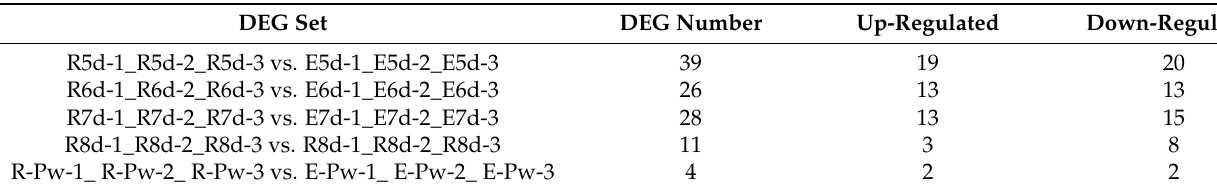
Table 1. miRNA count among different tissues.